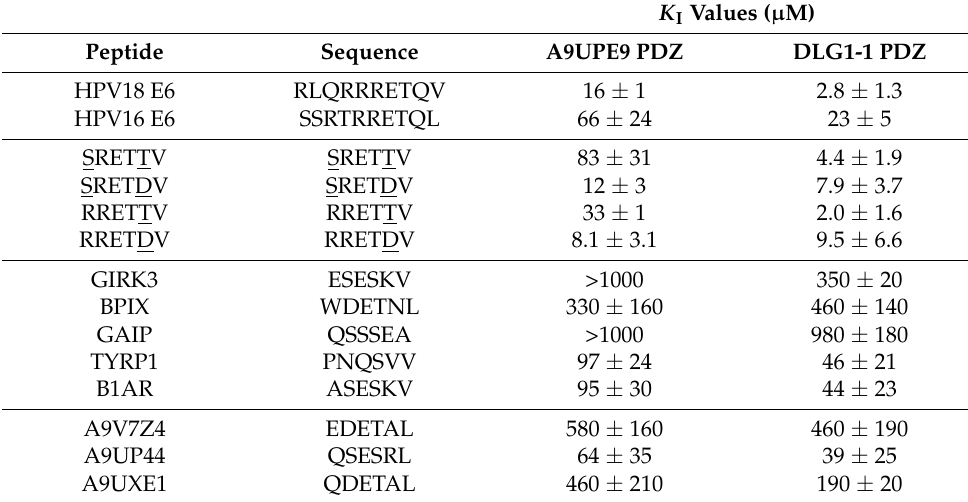
Table 3. Binding affinities for the A9UPE9 and DLG1-1 PDZ domains, determined by fluorescence polarization experiments. For all, F*- HPV18 E6 was used as a reporter peptide, and values reflect at least triplicate experiments. Differences as compared with HPV18 E6 are underlined, as rele- vant. Lines indicate related clusters of peptides: HPV sequences, HPV18 E6 variant sequences, SNX27/SHANK1/GIPC targets, and mbSHANK M. brevicollis targets, respectively. K I Values ( µ M) Peptide Sequence A9UPE9 PDZ DLG1-1 PDZ HPV18 E6 RLQRRRETQV 16 ± 1 2.8 ± 1.3 HPV16 E6 SSRTRRETQL 66 ± 24 23 ± 5 SRETTV SRETTV 83 ±